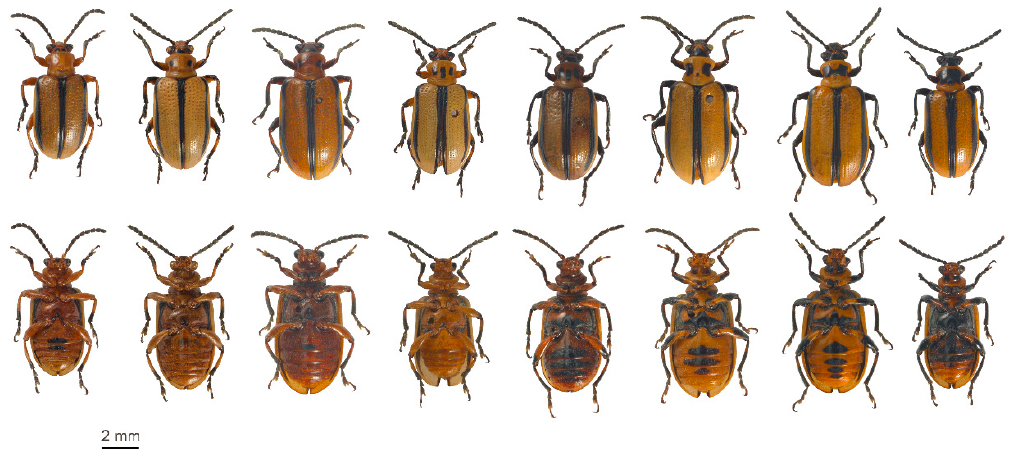
Figure 4. Lema daturaphila : main color patterns in South African specimens, in dorsal (upper row) and ventral (lower row) view.